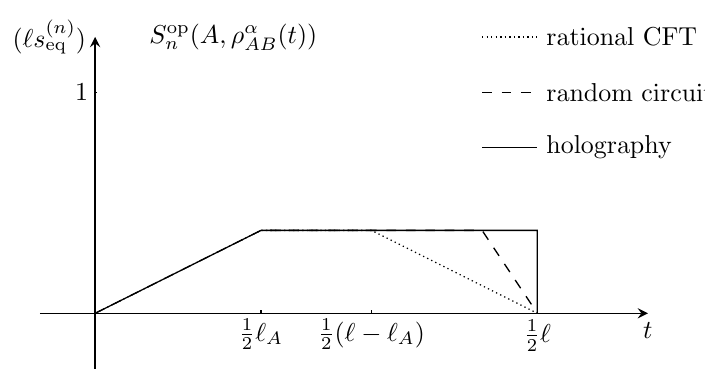
Figure 24 . The growth-plateau-drop pattern in three classes of